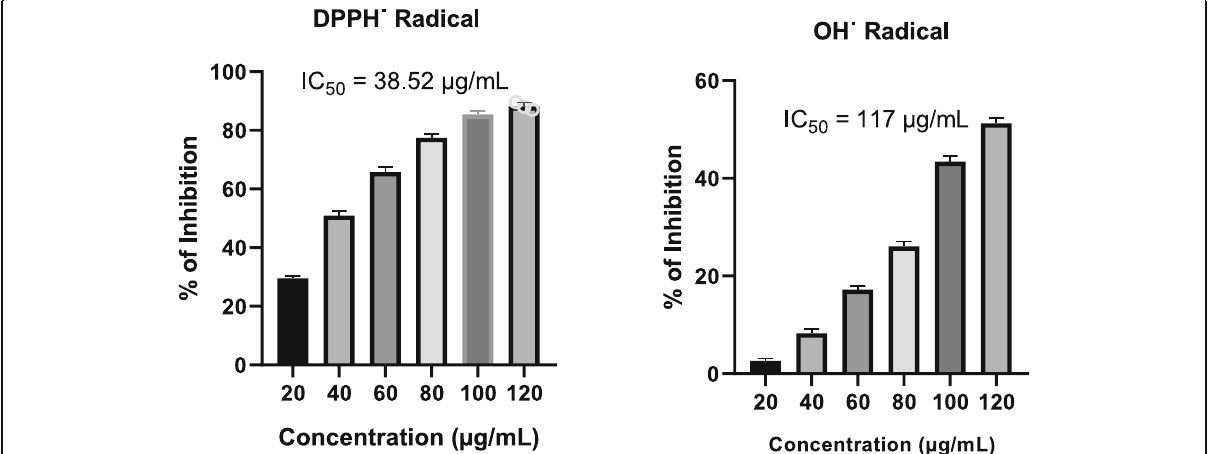
Fig. 2 DPPH ● radical and OH ● radical scavenging activities of the root extract of S. heyneanus . The results represent mean of triplicates along